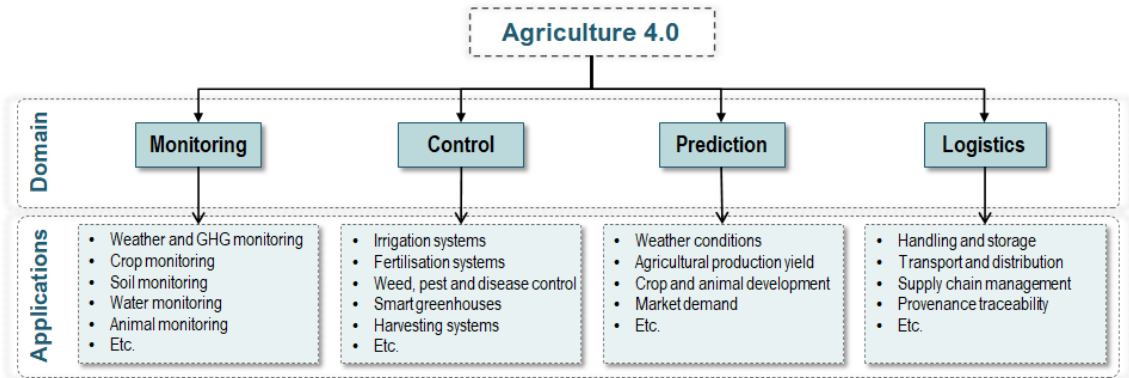
Figure 7. Distribution of Agriculture 4.0 applications domains and respective examples of applications